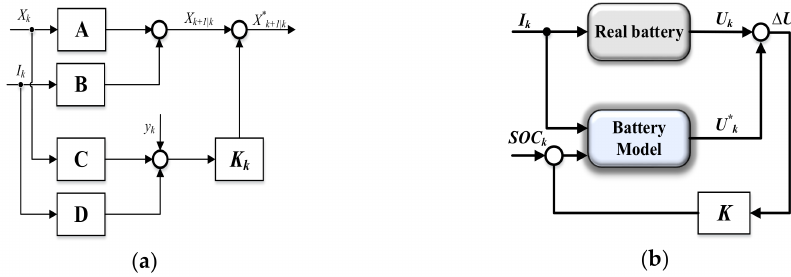
Figure 9. ( a ) The structure for EKF calculation; ( b ) The schematic diagram of EKF on SOC estimation.